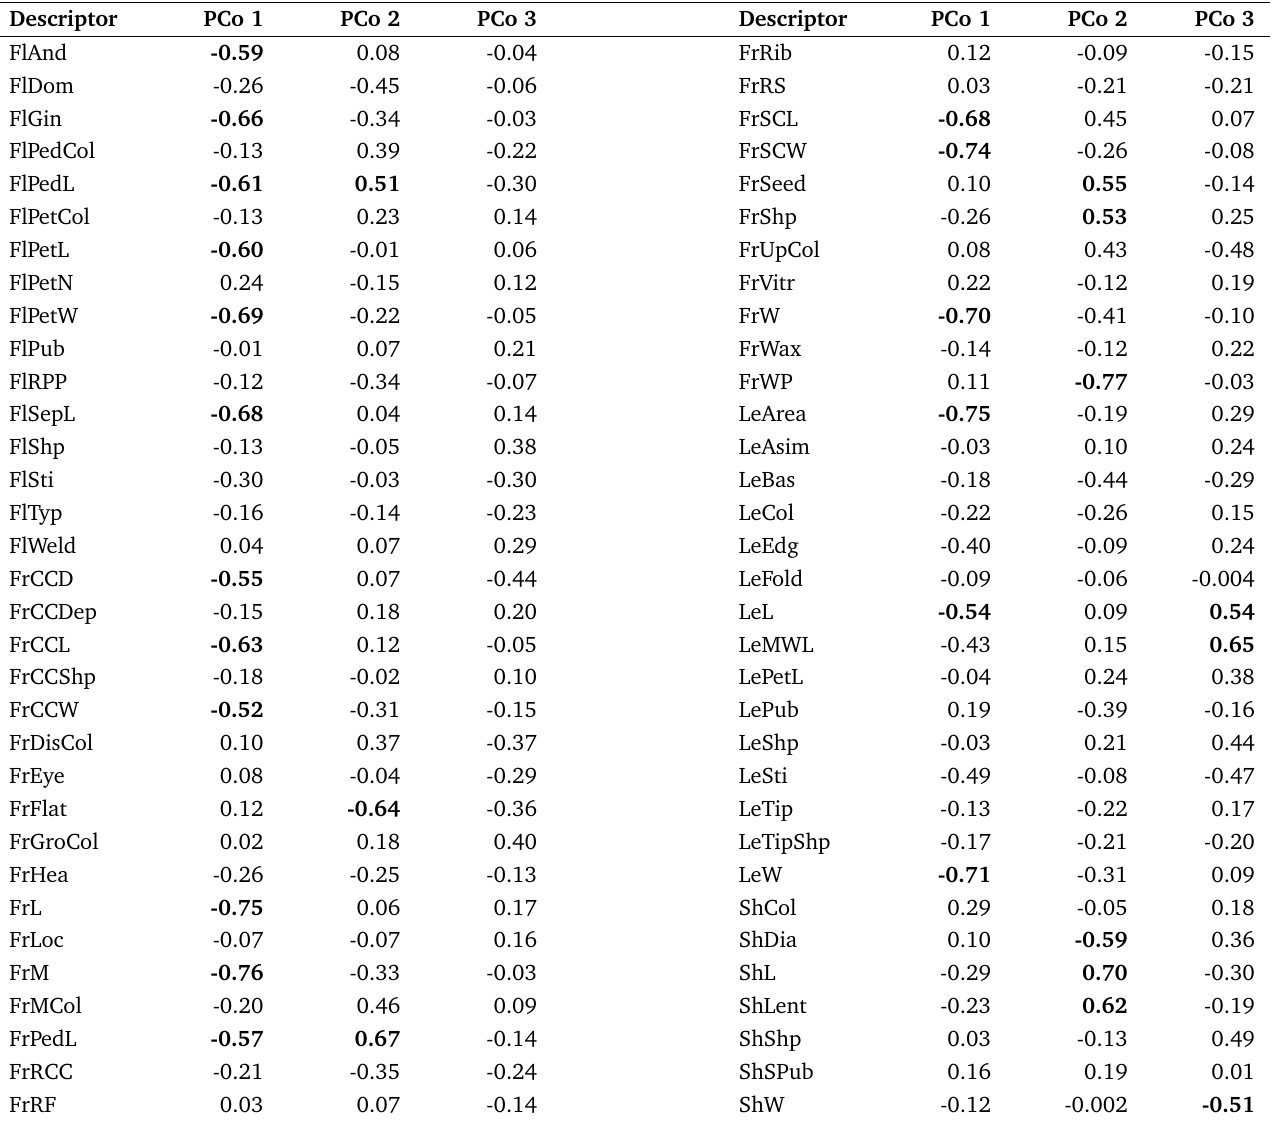
Table 5. Correlation coefficients between the first three principal coordinates (PCo) and the morphological descriptors, abbreviated as in Table 3. Eigenvalues below -0.5 and above 0.5 are highlighted in